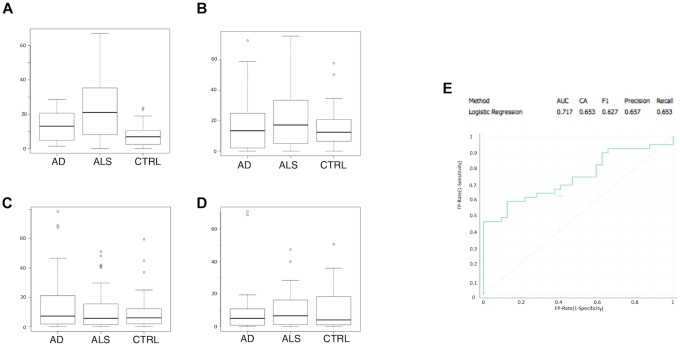
CD45+/Annexin V+ MVs is the most informative feature to discriminate ALS group from AD patients and healthy matched control groups. Boxplot of percentage of marker positive MVs are shown for ALS, AD, and control samples: (A) CD45+/Annexin V+; (B) CD235a+/Annexin V+; (C) CD31+/Annexin V+; (D) CD61+/Annexin V+; (E) ROC curve for logistic regression with an AUC of 0.717 and an accuracy of 0.653.